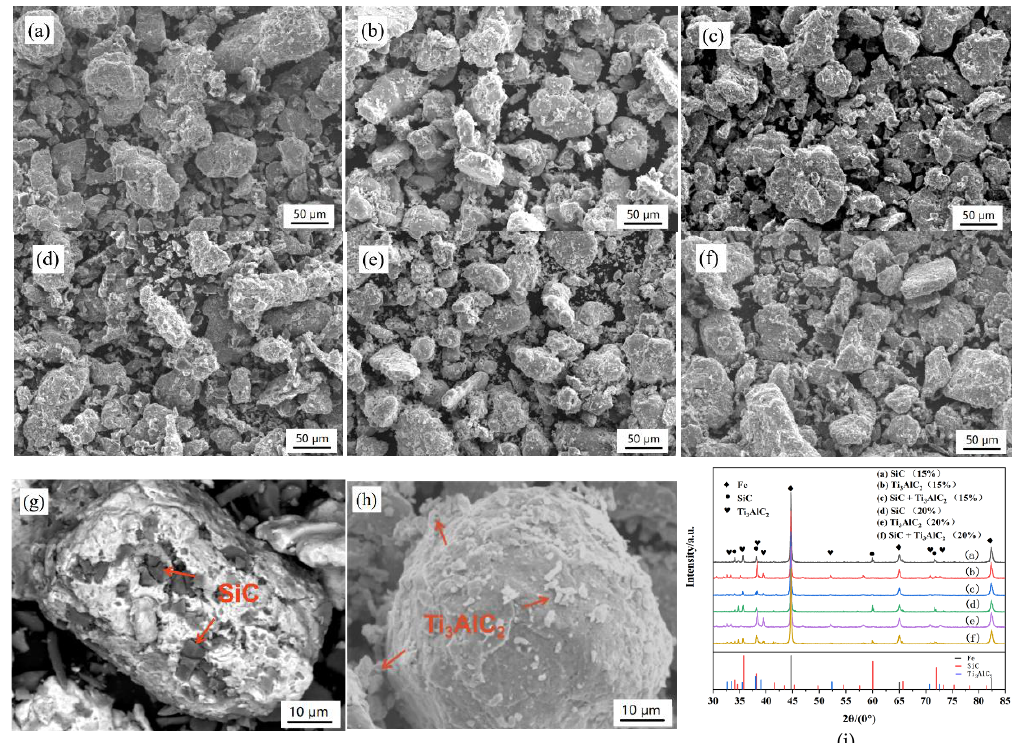
Figure 1. SEM micrographs and XRD patterns of mixed particles after ball-milling: ( a ) 15% SiC, ( b ) 15% Ti 3 AlC 2 , ( c ) 15% (SiC + Ti 3 AlC 2 ), ( d ) 20% SiC, ( e ) 20% Ti 3 AlC 2 , ( f ) 20% (SiC + Ti 3 AlC 2 ), ( g ) close-up of SiC and Fe powers, ( h ) close-up of the Ti 3 AlC 2 and Fe powders, and ( i ) XRD results.